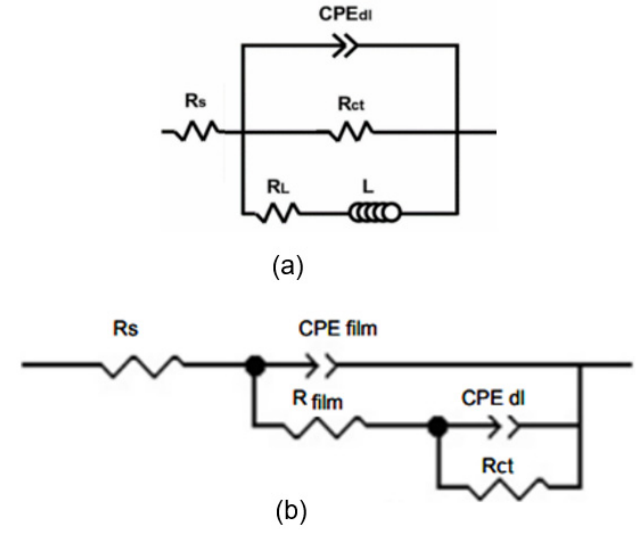
Figure 20. The equivalent circuit used for ( a ) A356 base sample, and ( b ) Cr 3 C 2 -NiCr and WC-Co-Cr coatings.